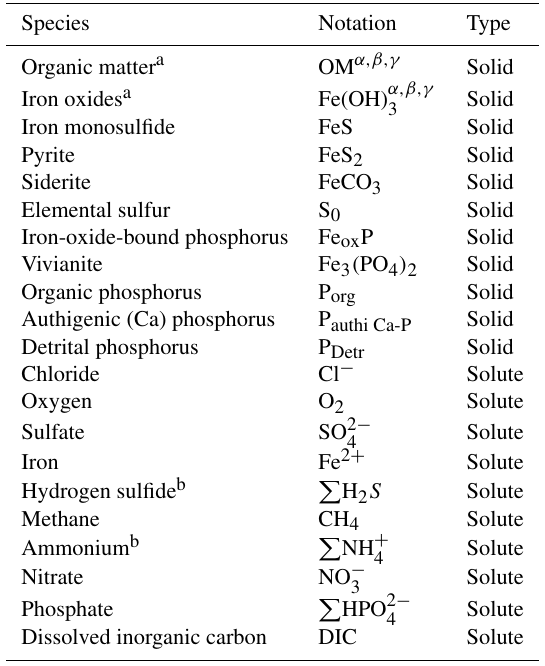
Table 2. Chemical species included in the diagenetic model.